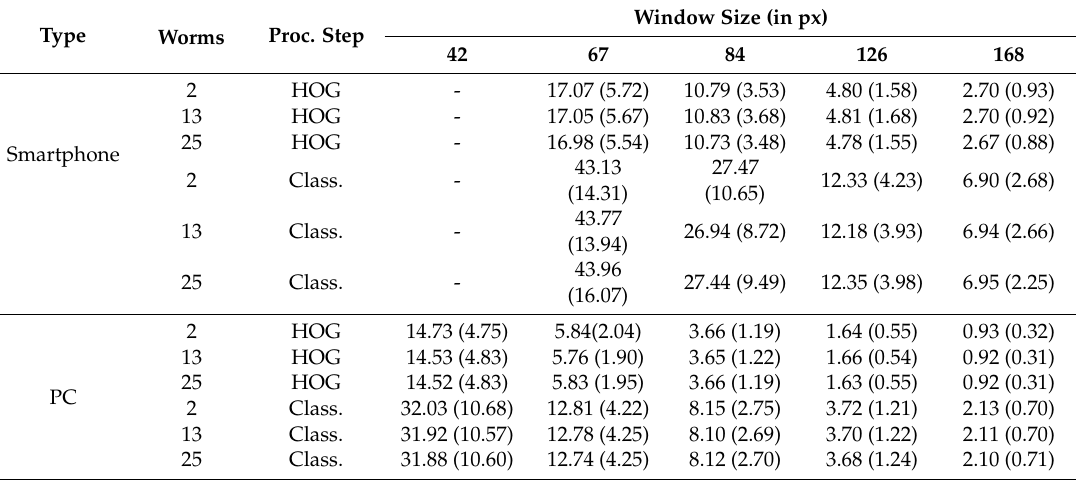
Table 3. Duration of processing steps (HOG: Generation of HOG features; Class.: Classification step) in seconds as mean and (SD) in relation to type of compute node, amount of worms per image and the applied window size (in px); Processing with a window size of 42 px on the smartphone resulted in system